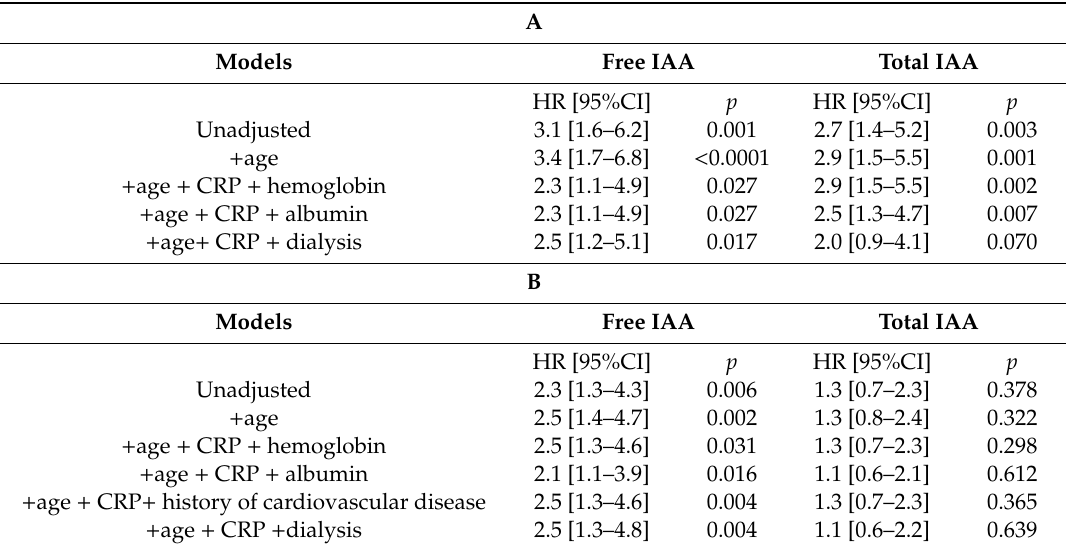
Table 2. A Cox proportional hazards analysis of plasma free and total IAA levels (stratified by the median) for predicting (A) all-cause mortality and (B) cardiovascular events in the non-transplanted CKD cohort (n = 140).